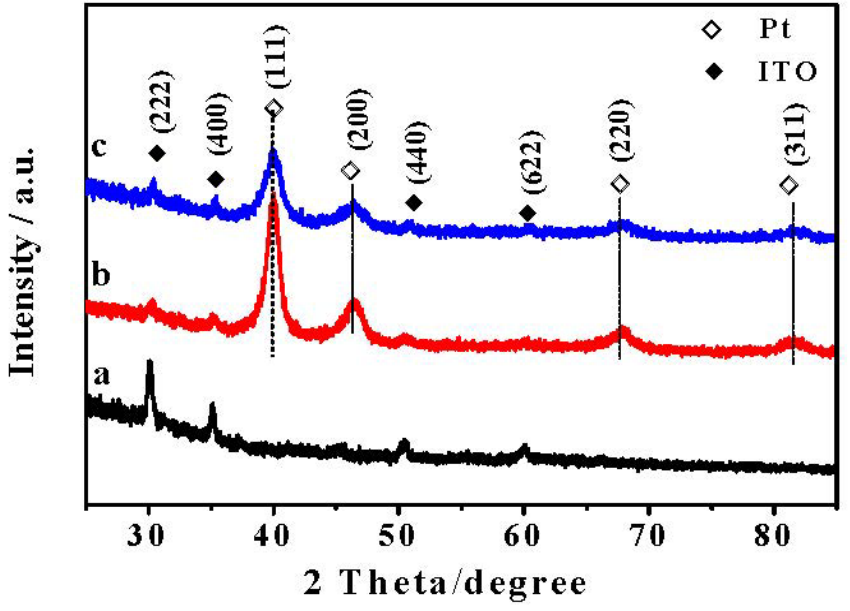
Figure 2. XRD patterns of the ( a ) rGO/ITO, ( b ) Pt/rGO/ITO and ( c ) PMo 12